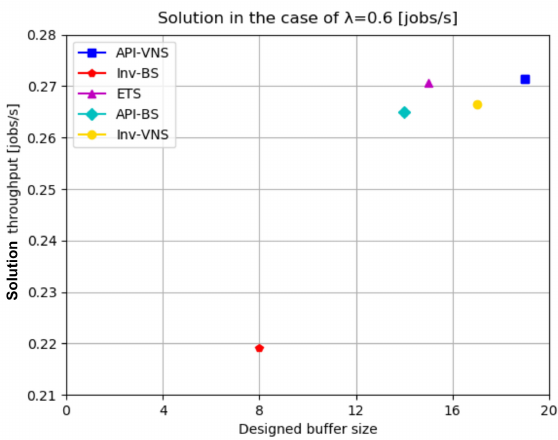
Figure 12. Scatter plot of designed bu ff er size vs. solution throughput for the five methods in the case of λ = 0.6 in experiment 1.